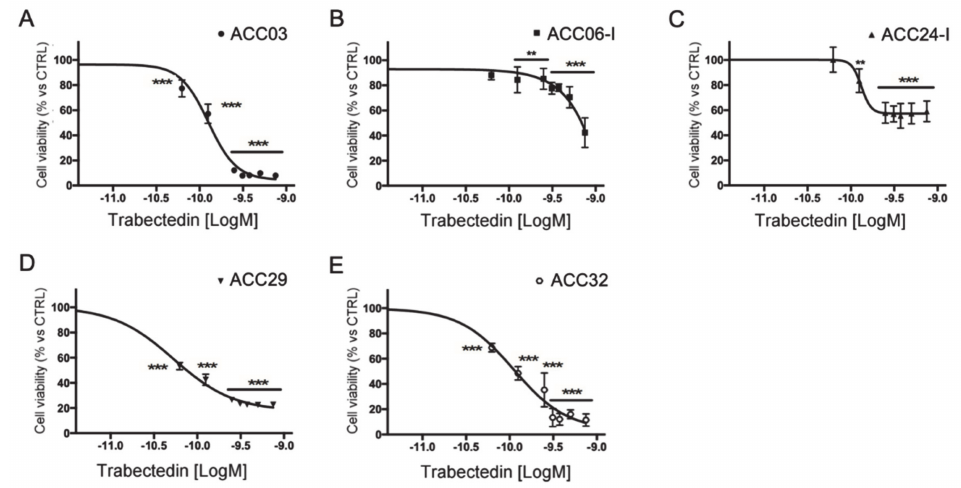
Figure 2. Cytotoxic e ff ect of trabectedin in primary cell cultures derived from ACC patients. Cells were treated with increasing concentrations of trabectedin (0.0625 nM–0.75 nM) for four days. Cell viability was analyzed by MTT assay. Results are expressed as percent of viable cells vs. untreated cells ± SD; ** p < 0.001; *** p < 0.0001. ( A ): ACC03 primary cell culture; ( B ): ACC06-I primary cell